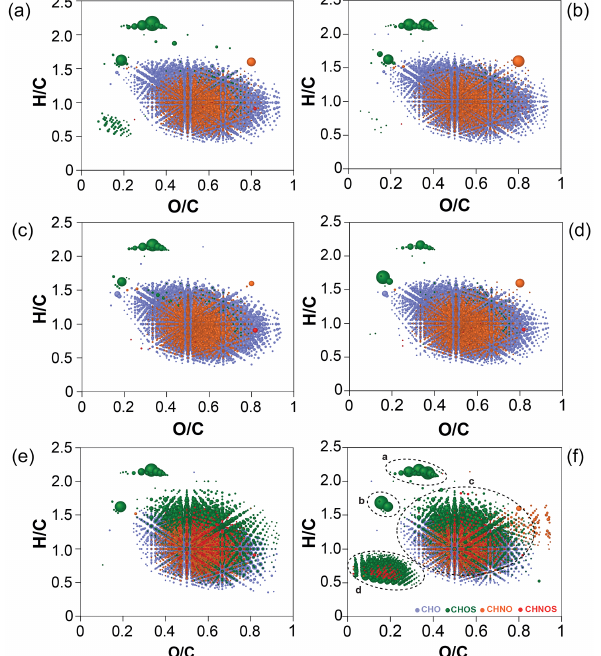
Figure 7. Van Krevelen diagrams of six wetlands SPE-DOM: (a) OKA-L, (b) OKA-S, (c) PAN-L, (d) PAN-S, (e) FCE-L, (f) FCE-S, obtained from negative electrospray 12T FTICR mass spectra. Only molecular assignments bearing combinations of C, –H, –O, –N, and –S atoms are shown; color coded according to molecular series as follows: CHO, blue; CHOS, green; CHNO, or- ange; CHNOS, red. Bubble areas reflect the relative intensities of re- spective mass peaks. (f) Labels for CHOS compounds correspond to key molecules, section (a): saturated sulfolipids; section (b): unsatu- rated sulfolipids; section (c): common CHOS compounds in DOM, possibly sulfonated carboxylic-rich alicyclic compounds (CRAM); d: aromatic black sulfur.